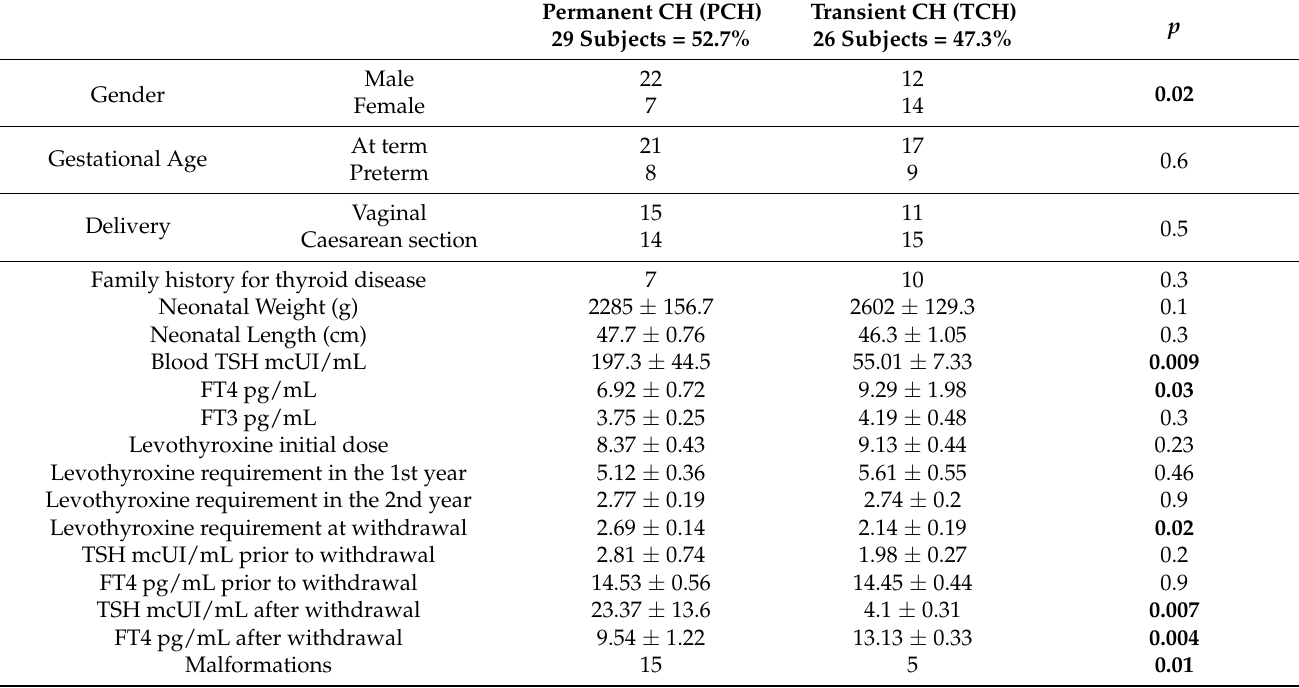
Table 1. Demographic, clinical and hormonal data of the 55 infants affected by CH and eutopic thyroid